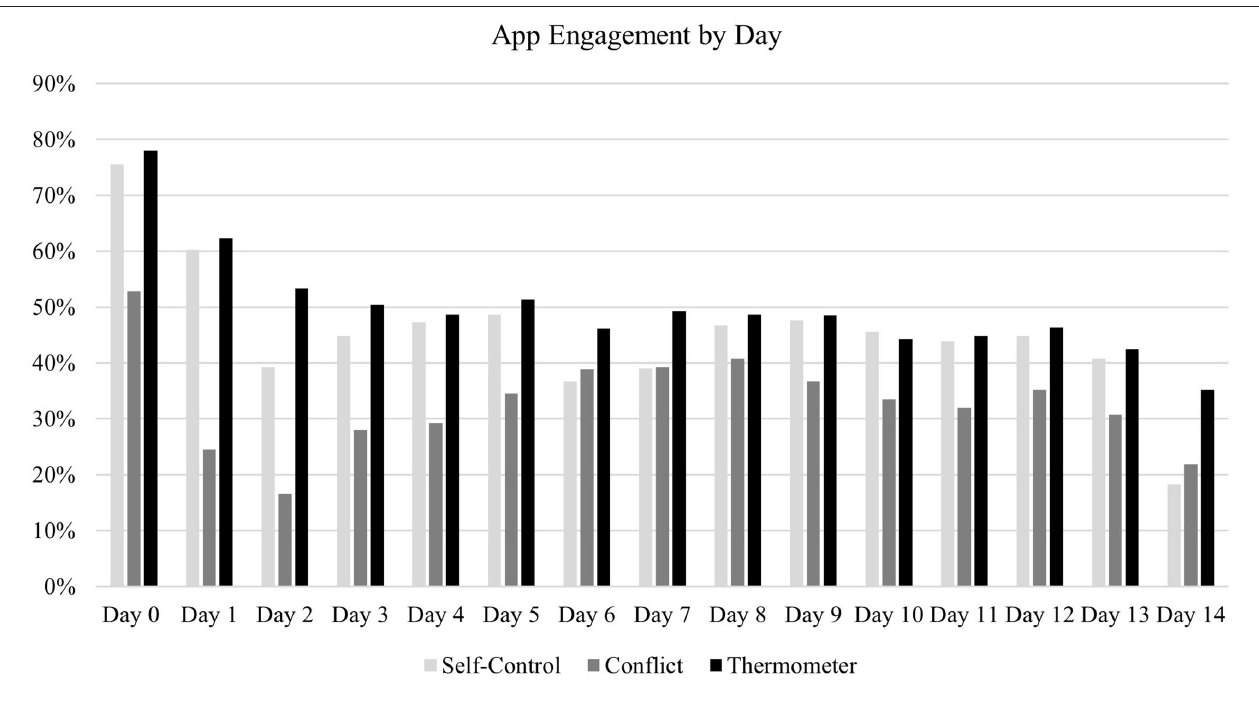
FIGURE 1 | CharacterMe engagement across time.